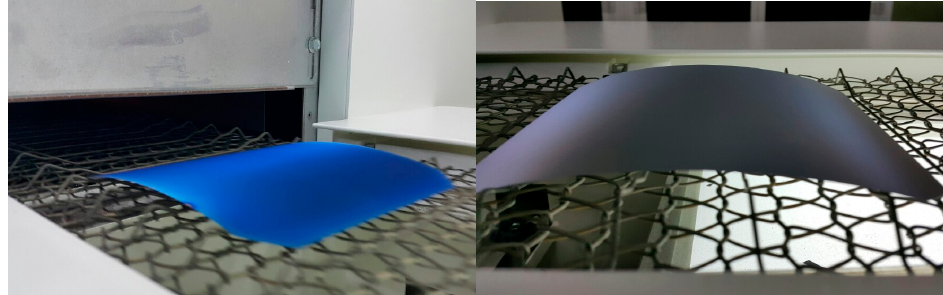
Figure 3. Bowing phenomenon after firing process of c-Si solar cell which is partially processed.